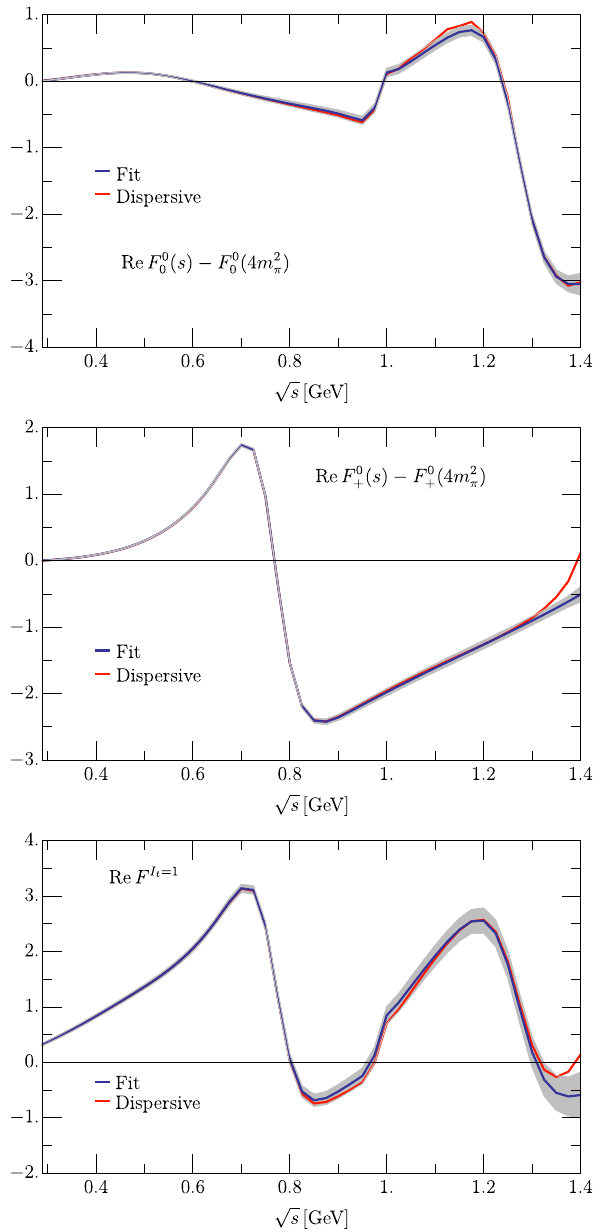
Table 13 Average discrepancies ¯ d 2